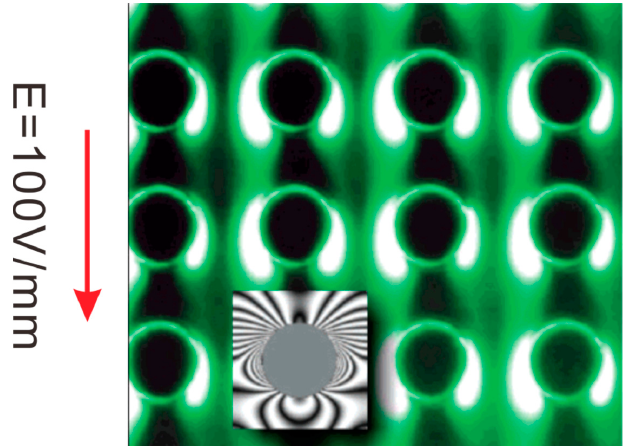
Figure 9. Dielectrophoretic trapping (DEPT) of fluorescent particles by an array of insulating pillars. The pillars are 33 µm in diameter and with a center-to-center separation of 63 µm. The inset picture shows the isopotential lines around one pillar from numerical simulation. Dielectrophoretic traps are defined by regions with isopotential lines bending back onto a pillar surface. Reprint from [112].